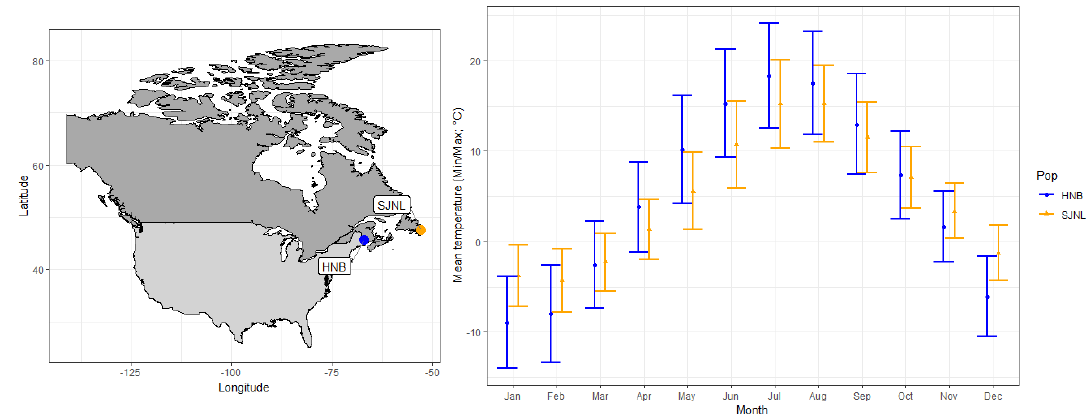
Figure 2 – Locations of Harvey Station (HNB, Canada; Blue) and St Johns (SJNL, Canada; Orange), and their monthly variation of temperatures recorded from 1970 to 2000. Dots depict mean monthly temperatures, with whiskers extending from minimum to maximum mean temperatures. These data were extracted from the WorldClim